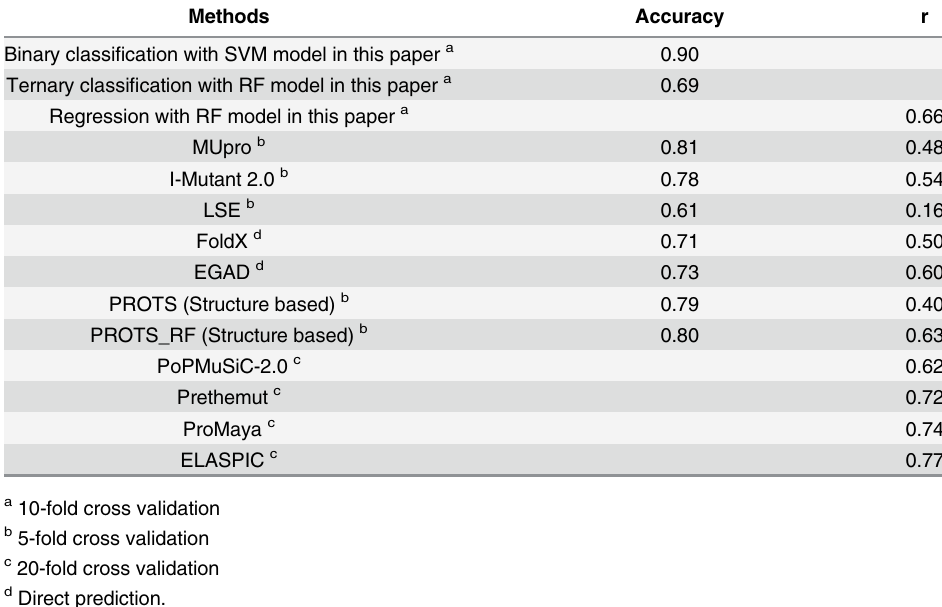
Table 14. Comparison of ddG prediction